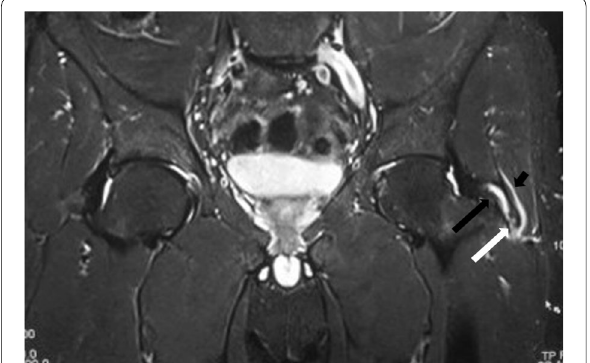
Fig.2 Coronal PDFS: left GTPS; fluid signal is seen superficial to the gluteus minimus tendon within the greater trochanteric bursa (short black arrow). Partial thickness tear of the insertional fibers of the gluteus minimus (white arrow). Note fluid within the sub-gluteus